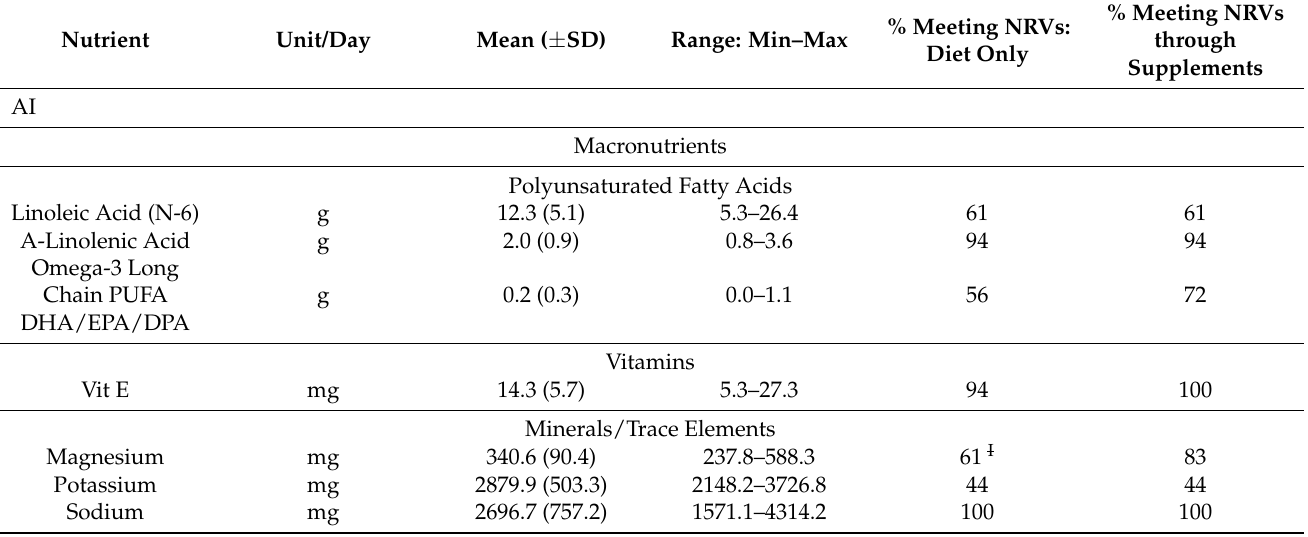
Table 2. Mean ( ± SD) and Range of Nutrient Intake of Women in the present study and Percentage of Appropriate Nutrient Reference values Met Based on Pregnant Women Aged 19–50